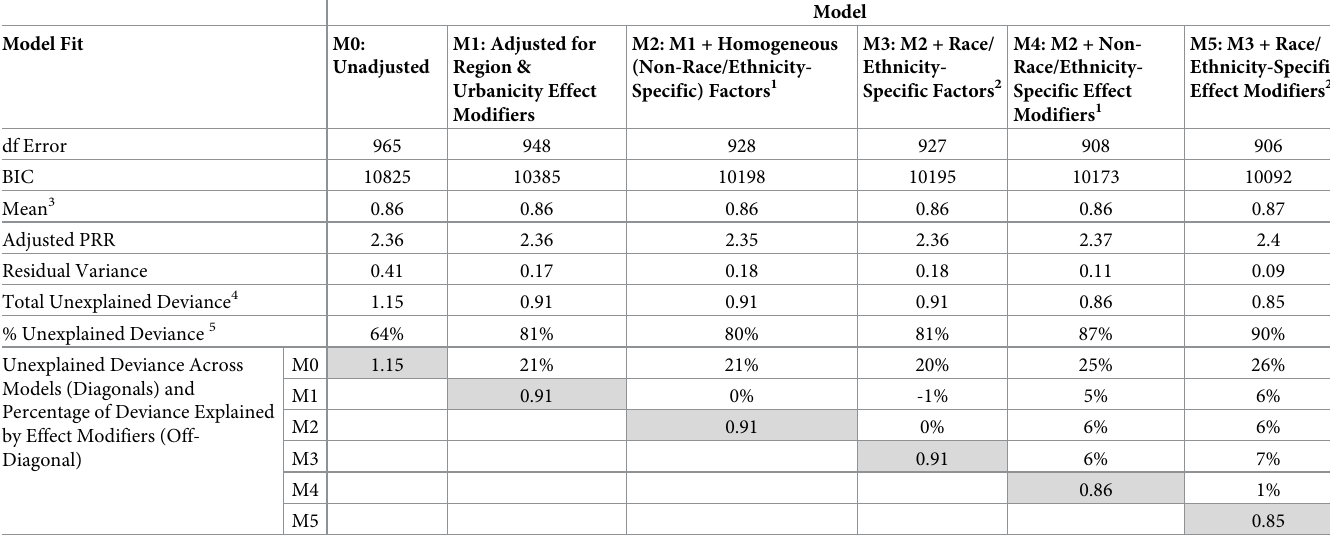
Table 3. Comparison of unexplained deviance in disparities in multi-variable models (N = 485 counties).